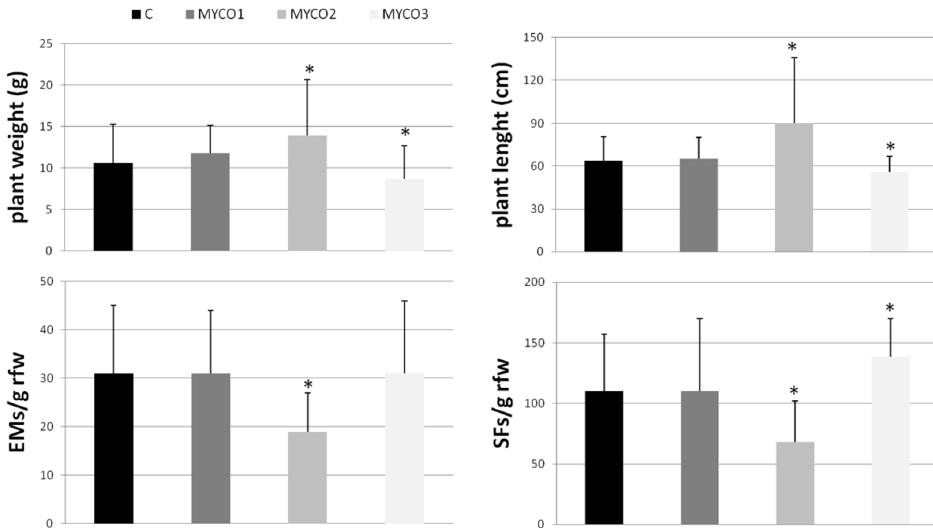
Figure 6. Plant growth and nematode infection factors of tomato plants untreated (C) and treated with 0.5, 1.0, and 2.0 g Myco/plant (MYCO1, MYCO2, and MYCO3, respectively). Plants were inoculated with RKN J2s and harvested after 40 days. Plant growth was evaluated by plant weight and length; nematode infection by the numbers of egg masses (EMs) and sedentary forms (SFs) per gram of root fresh weight (g rfw). Values are expressed as mean ( n = 12) ± SD; means of untreated plants factors were separated from those of Myco-treated plants by a t -test (* p < 0.05).